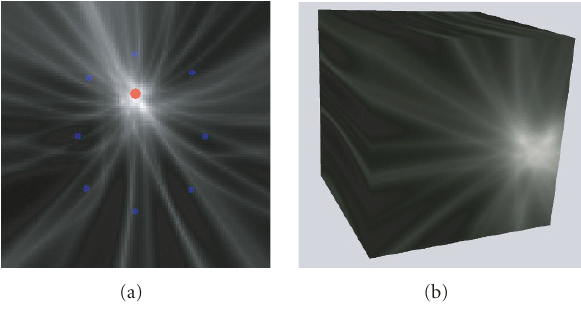
Figure 6: (a) A 2D probability histogram for source location ob- tained by sampling a weighted sum of hyperbolas corresponding to the time-di ff erence of arrival to all microphone pairs (shown in blue). We pick the maximum value (in red) in the histogram as the location of the frequency band at each frame. (b) A cut through a 3D histogram of the same situation obtained by sampling hyper- boloid surfaces on a 3D